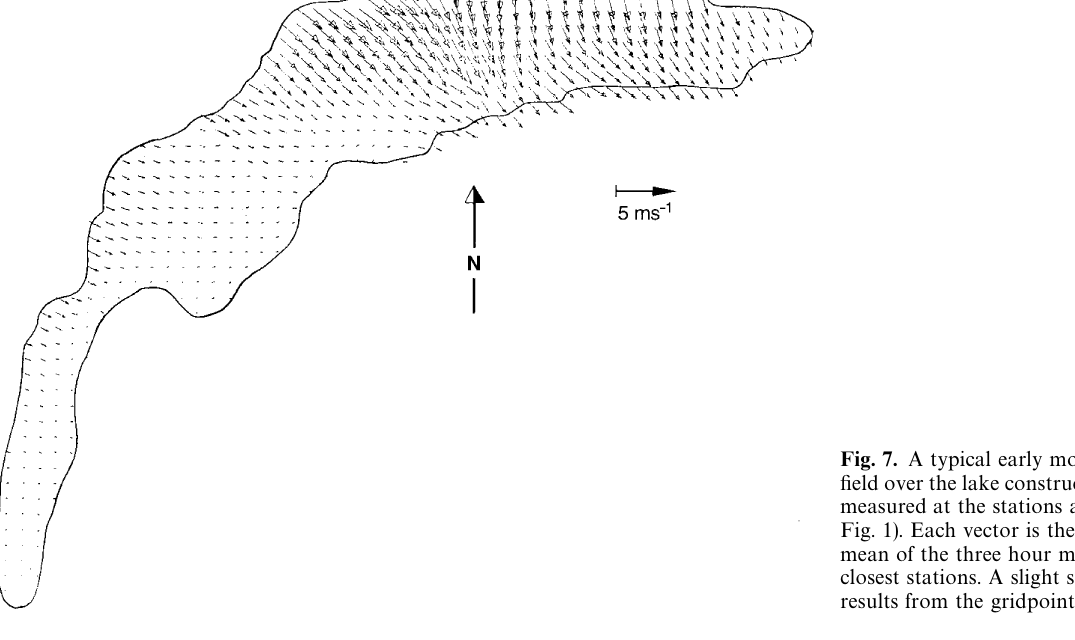
Fig. 7. A typical early morning (3:00) wind field over the lake constructed from wind data measured at the stations around the lake (see Fig. 1). Each vector is the distance-weighted mean of the three hour means at the three closest stations. A slight shoreline distortion results from the gridpoint